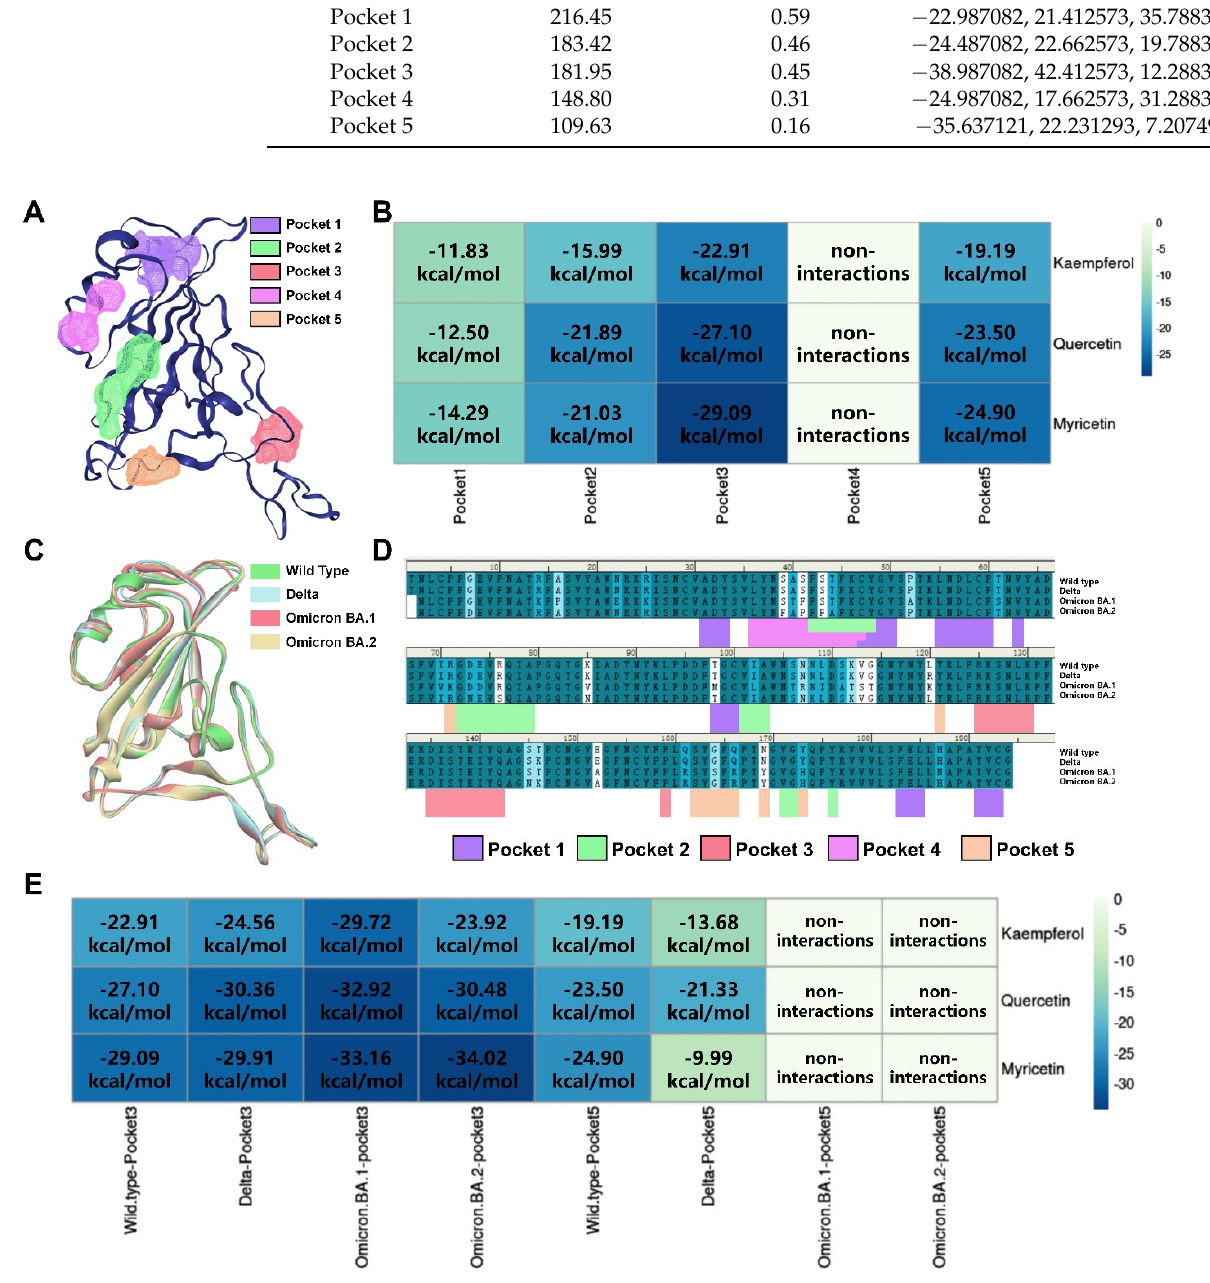
Figure 5. Prediction of the binding models of flavonols by computational modeling study. ( A ) Possible binding sites of SARS-CoV-2 spike RBD identified by DoGSiteScorer. ( B ) Heatmap of molecular docking scores for flavonols. ( C ) The 3D structure superimposition of spike RBD from different mutant strains. ( D ) Align sequence of spike RBD from different mutant strains. ( E ) Heatmap of molecular docking scores of Pocket 3 and Pocket 5 from different mutant strains for flavonols, supporting that Pocket 3 might be the key druggable binding site for flavonols to inhibit SARS ‐ CoV ‐ 2 infection.